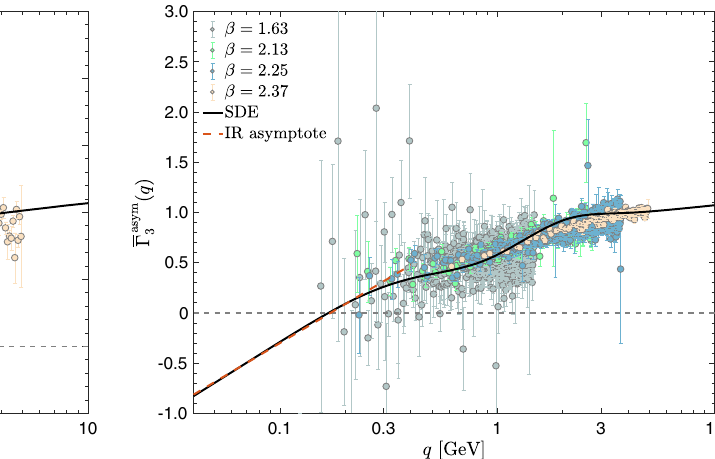
Fig. 6 Left panel: The form factor of the three-gluon vertex in the symmetric configuration, (cid:2) sym 1 ( s ) , obtained from lattice QCD (circles in different colors for each setup) and from the SDE-based approach